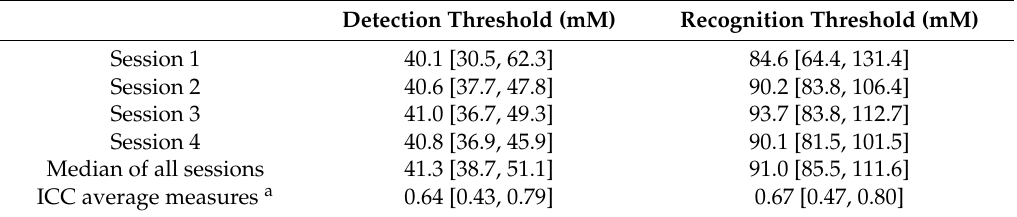
Table 1. Glucose detection and recognition thresholds at the four different sessions.